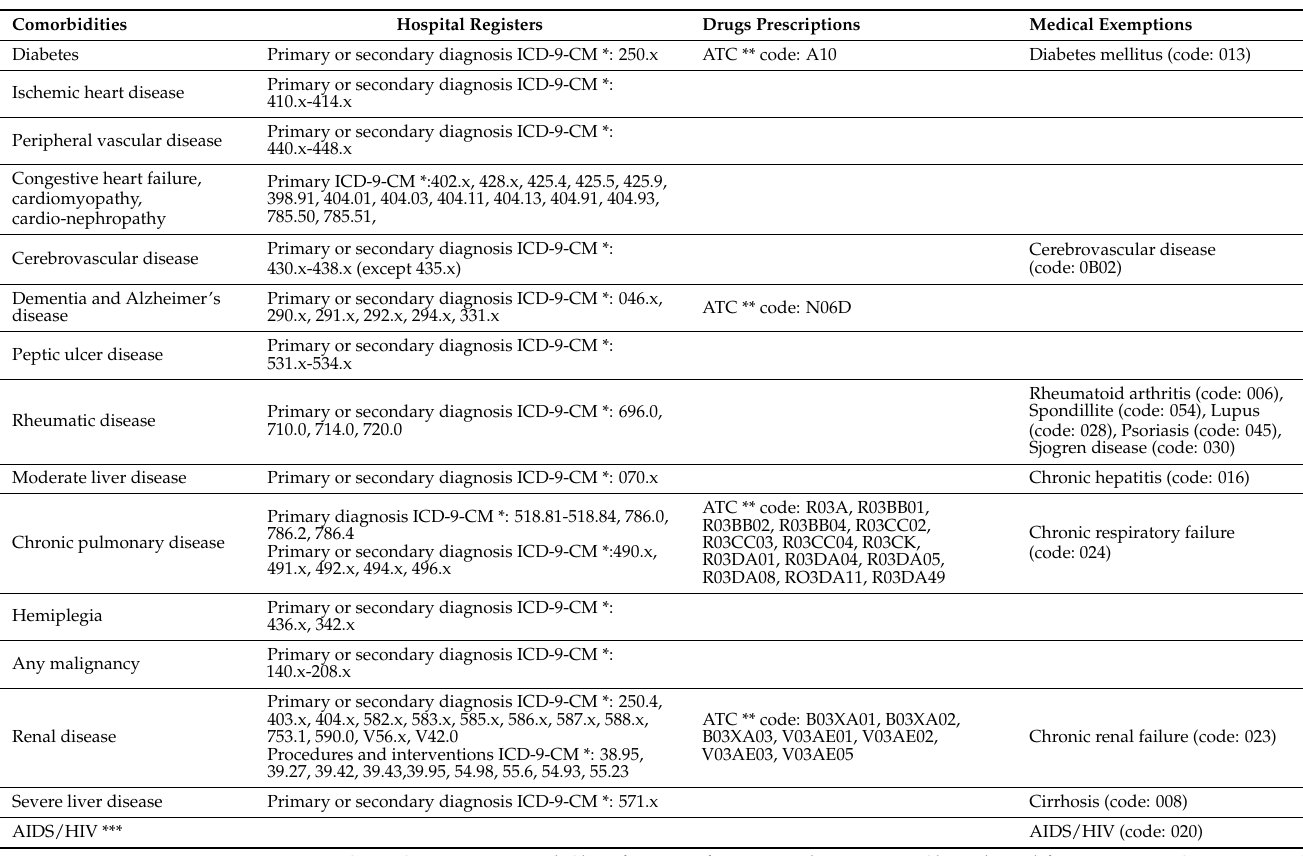
Table A1. Algorithm for the definition of